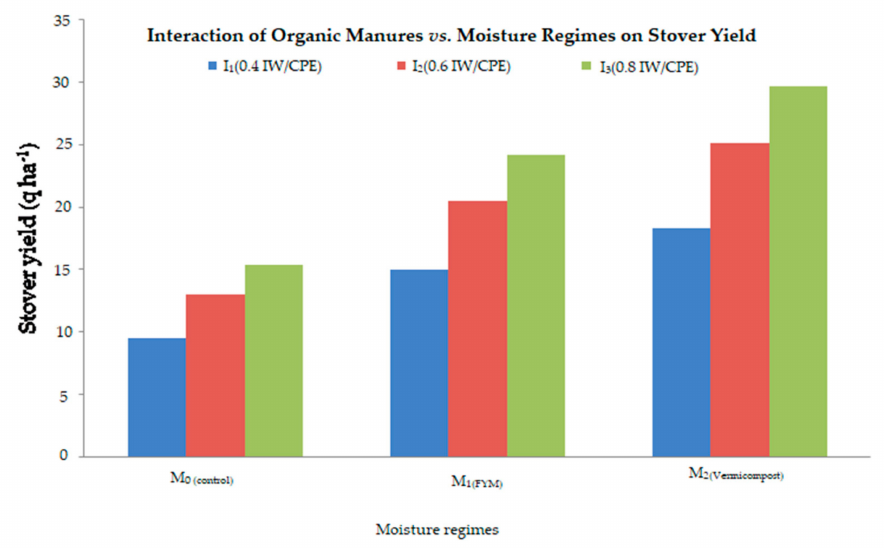
Figure 4. Interaction effect of organic manures and moisture regimes on stover yield (q ha − 1 ) of mustard